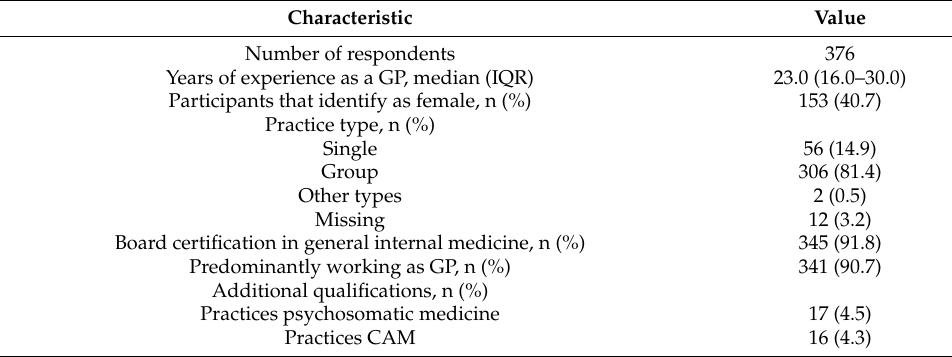
Table 1. Characteristics of survey participants. Abbreviations: CAM, complementary and alternative medicine; GP, general